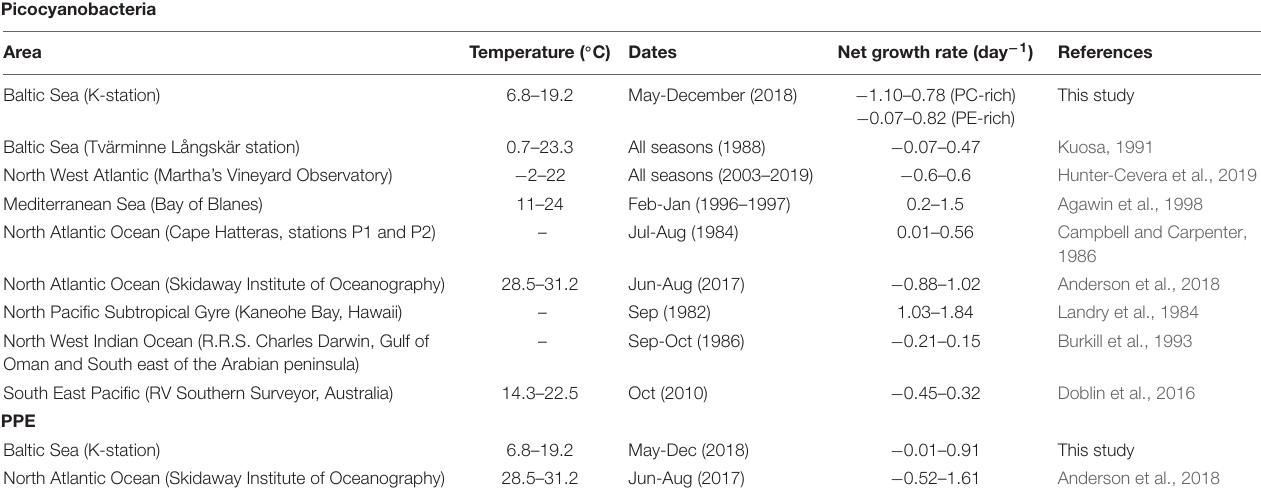
TABLE 2 | Compilation of reported net growth rates (day − 1 ) of Synechococcus sp. and PPE from incubation